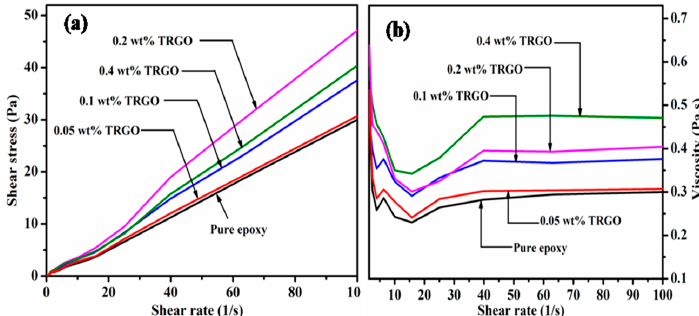
Figure 3. Effects of thermally reduced graphene oxide on the ( a ) Shear stress ( b ) Viscosity of epoxy resin as a function of shear rate.